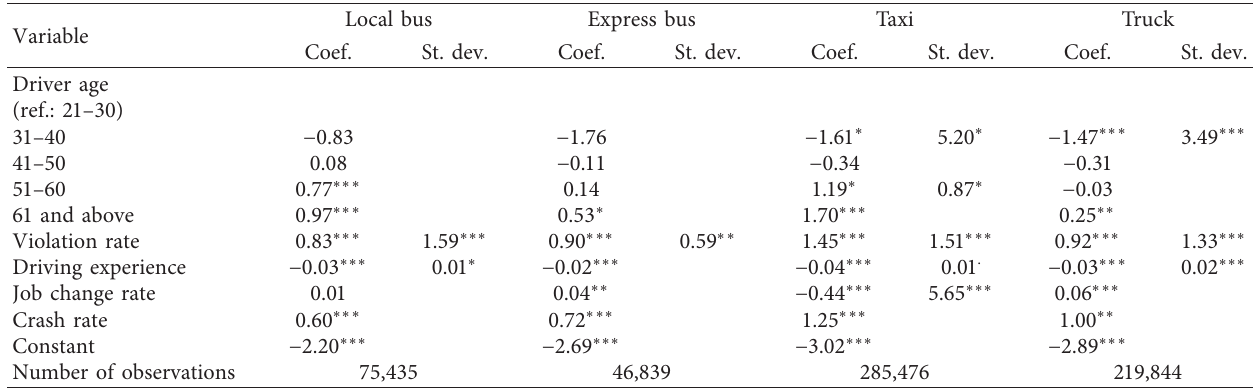
Table 6: Model estimation results for significant independent